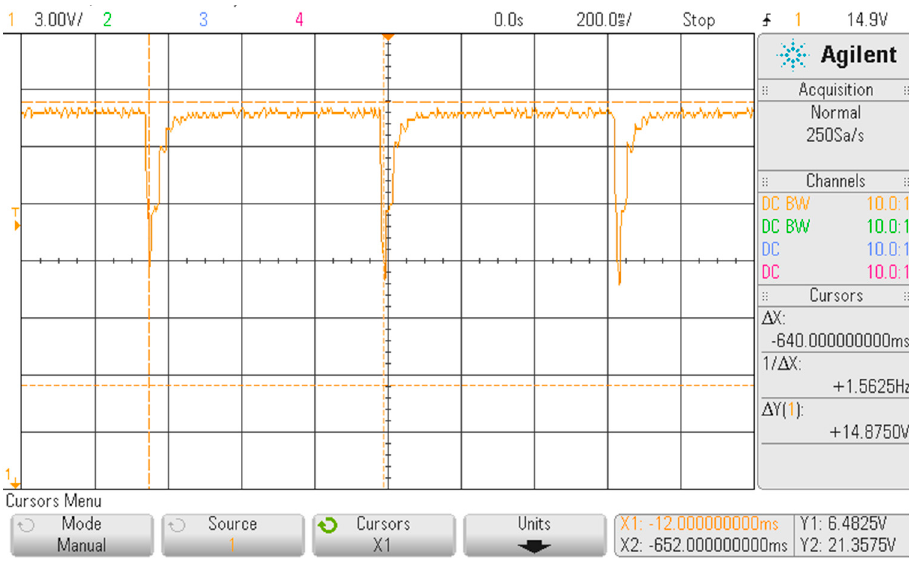
Figure 6. Displayed waveform on the oscilloscope with the FHRS switch in Position “1”.